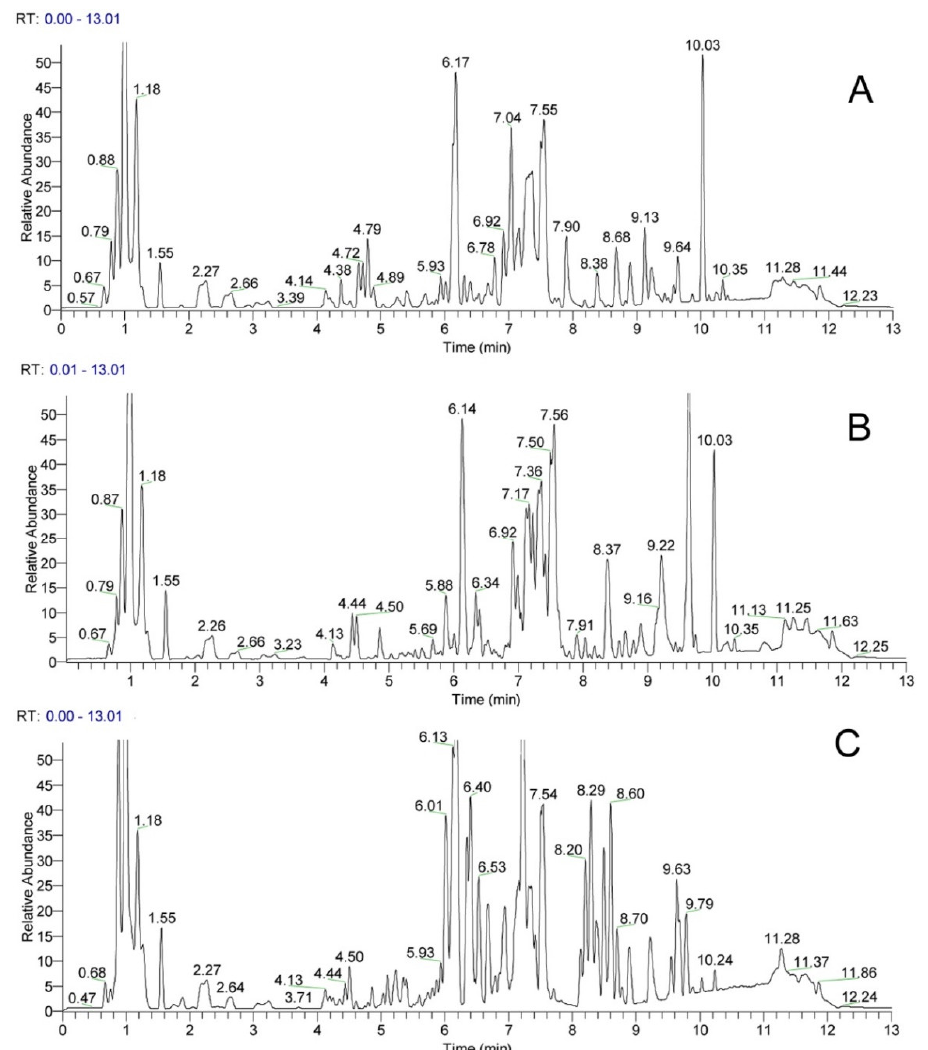
Figure 2. The base peak chromatogram of the roots and rhizomes of PJ ( A ), PM ( B ), and PZ ( C ) in negative mode. Panax japonicas ( PJ ), Panax japonicus var. major ( PM ), Panax zingiberensis ( PZ ).